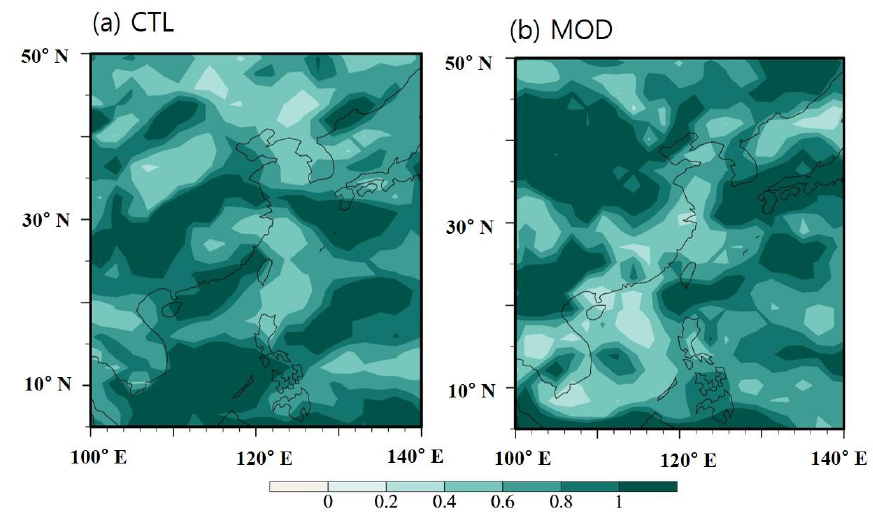
Figure 2. Signal-to-Noise ratio of precipitation forecast from: ( a ) CTL; and ( b ) MOD.